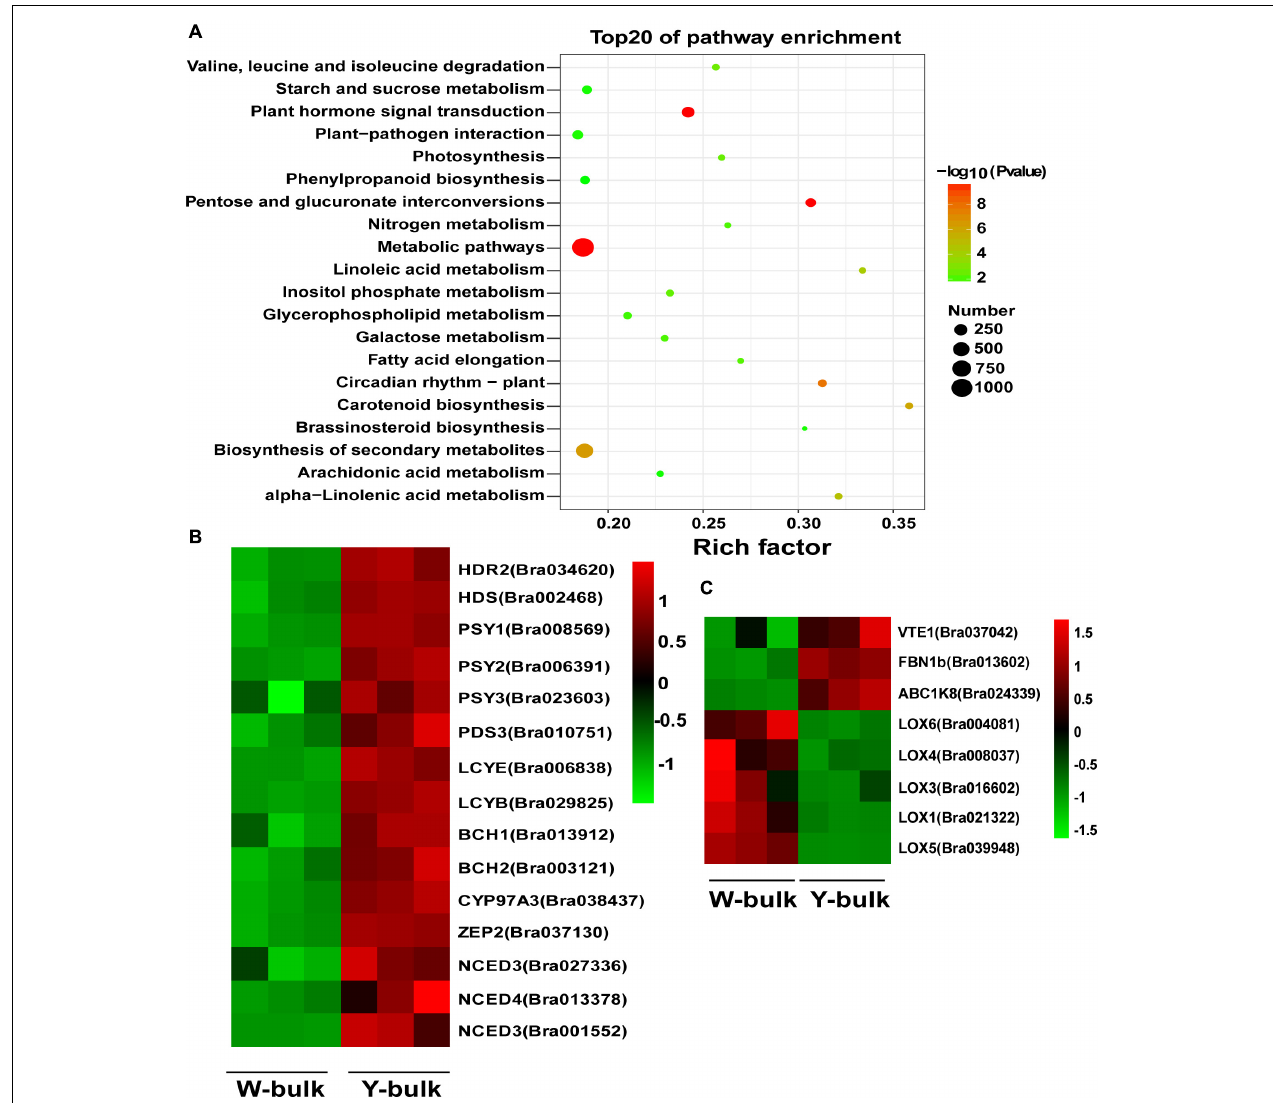
FIGURE 7 | Transcriptome analysis in yellow and white petals. (A) Scatter plot of top 20 enriched KEGG pathways. Rich factor is the ratio of the DEG number to the background number in a certain pathway. The size of the dots represents the number of genes, and the color of the dots represents the range of the -log10( p -value). (B) Differentially expressed genes involved in carotenoid biosynthesis and degradation. (C) Differentially expressed genes associated with proteins in PGs. The heatmap colors are shown in log10(FPKM). Three biological replicates of the W-bulk and Y-bulk are